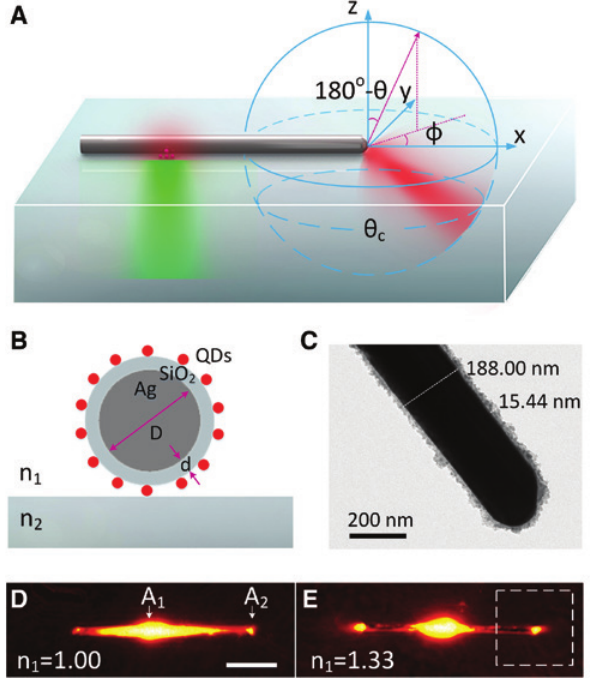
Figure 1: The designed structure and optical